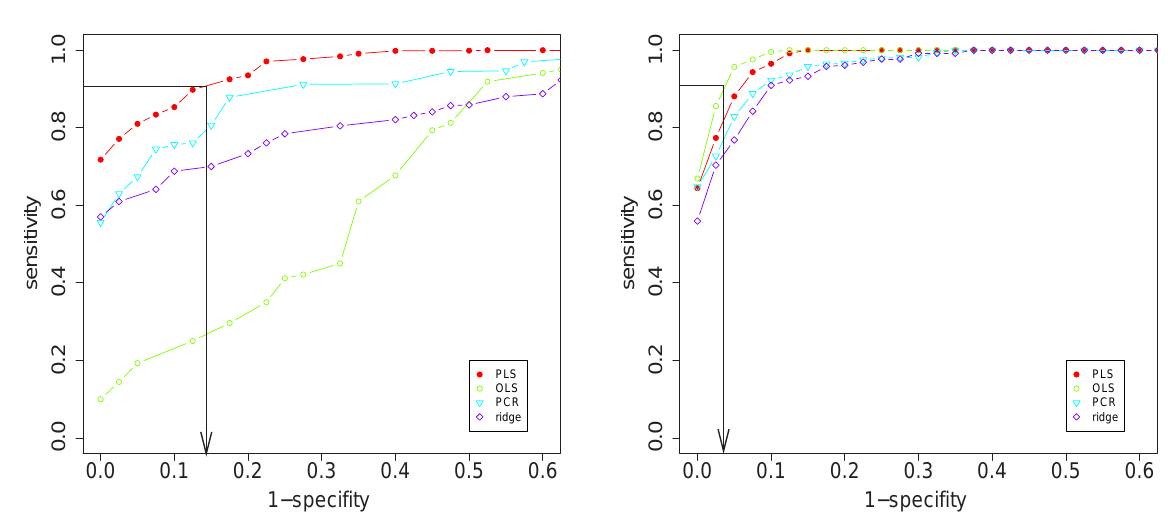
Figure 5: ROC-curves for results comparison of the coefficients method (left) and the correlation method (right). Parameters: p = 50 , C true = 0 . 8 . The arrows indicate the readout for specificities if sensitivities are fixed at sens = . 0 . 9